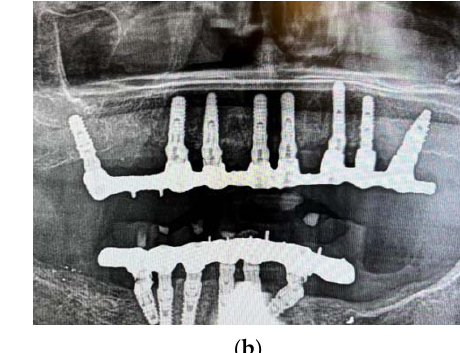
Figure 7. Transfer on implants to make the impression ( a ); healing caps on implants ( b ); prosthesis with immediate loading after 48 h ( c ).